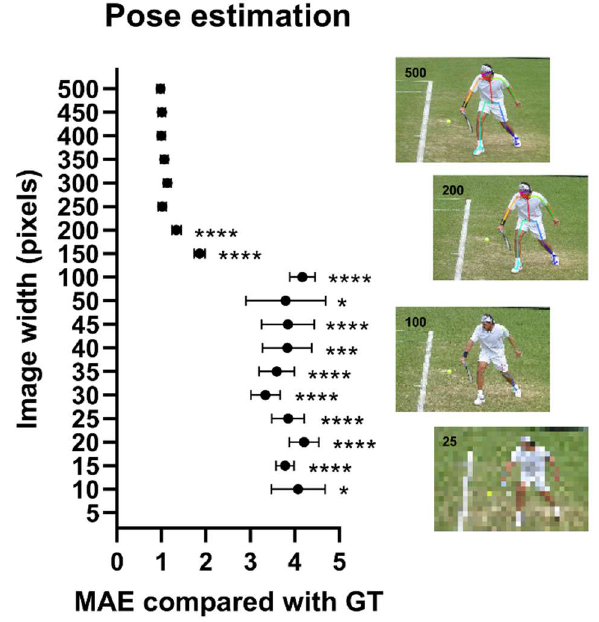
Figure 4. Model performance in the COCO body keypoint dataset as a function of image quality. Data points are mean absolute error values of model prediction as a function of image resolution. Inserts show images at different quality levels with overlaying model prediction. Data points ± error represent mean value ± SEM. Statistical significance levels were for one-way ANOVA with multiple comparisons using images of the best quality as the comparator. EAR: Eye aspect ratio; GT: Ground truth; MAE: Mean absolute error. * : p < 0.05, ** : p < 0.01; *** : p < 0.001; **** : p < 0.0001.